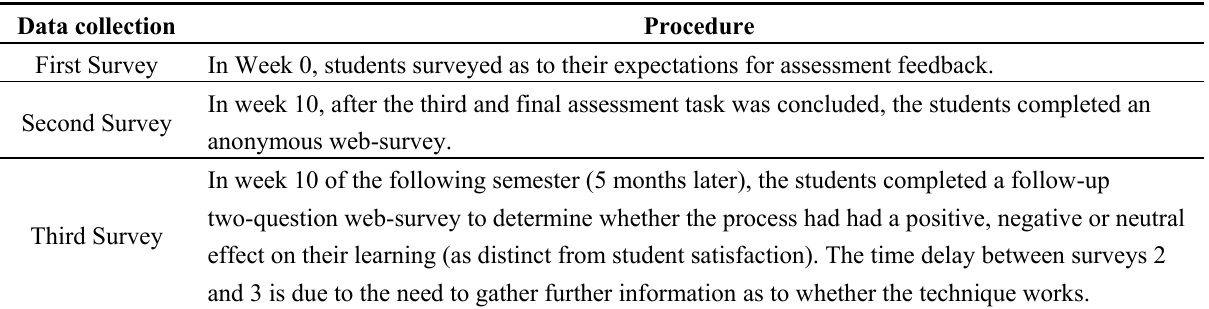
Table 1. Data Collection